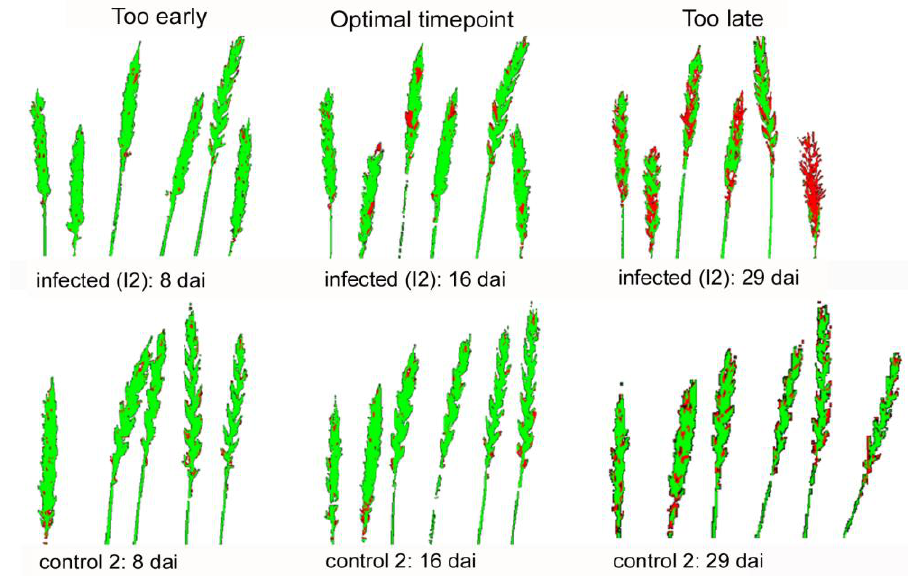
Figure 5. Samples of classification results using SAM classification (green: healthy classified tissues, red: diseased classified tissues). Upper row: infected ears, lower row: